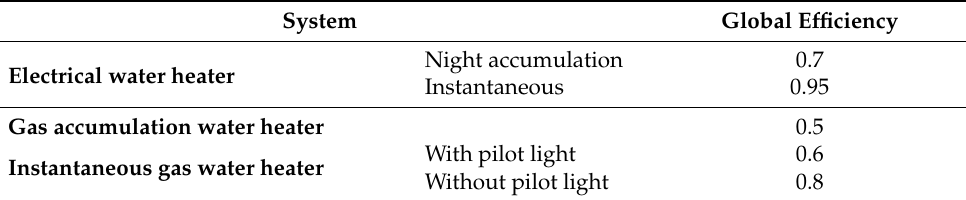
Table 10. Efficiency of hot water production systems.